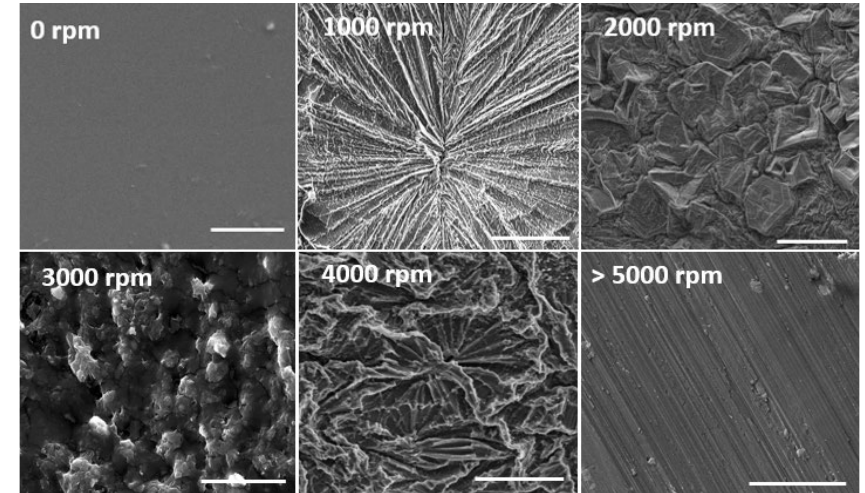
Figure 2. Surface morphologies of VFD-driven polyvinyl alcohol (PVA) hydrogels formed at different rotation speeds of the VFD tube. Scale bars are 50 μm. Images reproduced with permission from [66], copyright (2020) Springer.